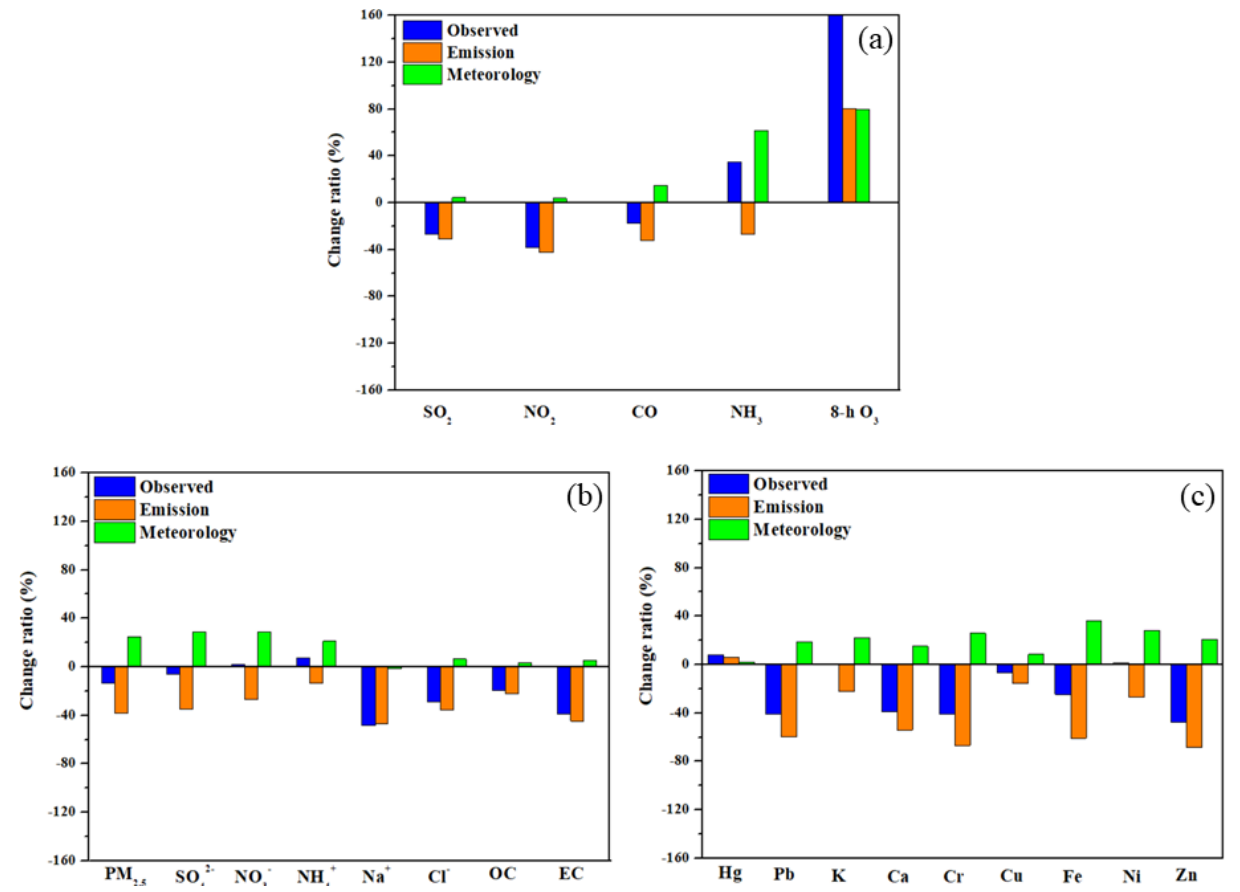
Figure 6. The changes in observed concentrations of multiple components between pre-lockdown (week 1–3) and post-lockdown (week 4– 13) against the changes derived from the emission and meteorological changes. The gaseous pollutants, water-soluble ions and carbonaceous aerosols, and trace metals are shown in (a–c) , respectively.